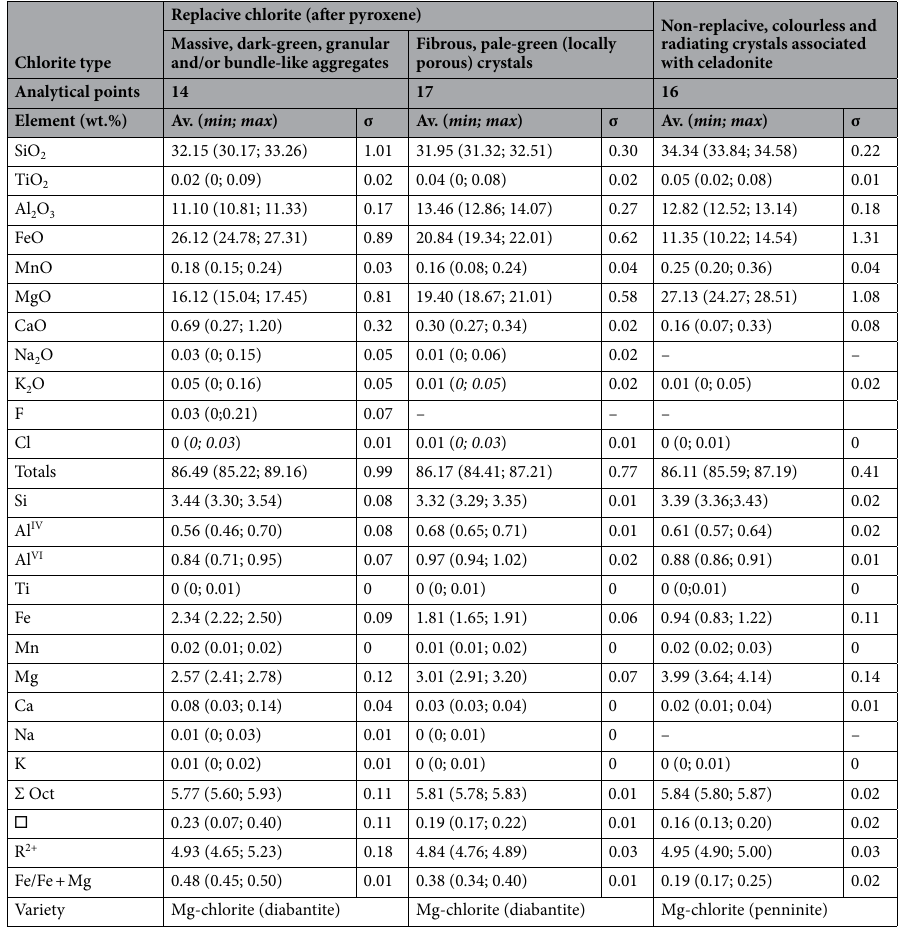
Table 6. Representative composition (EMPA) of replacive chlorite (after aegirine and/or augite) and chlorites associated with celadonite (based on 14 oxygen atoms). Note: Al IV = 4—Si IV a.p.f.u.; ΣT: tetrahedral occupancy (Si + Al IV ); ΣOct: octahedral occupancy(Al VI + Fe + Mg + Mn); □ : octahedral vacancy; R 2+ : sum of divalent cations (Fe + Mg + Mn) assuming all iron to be ferric (Fe 2+